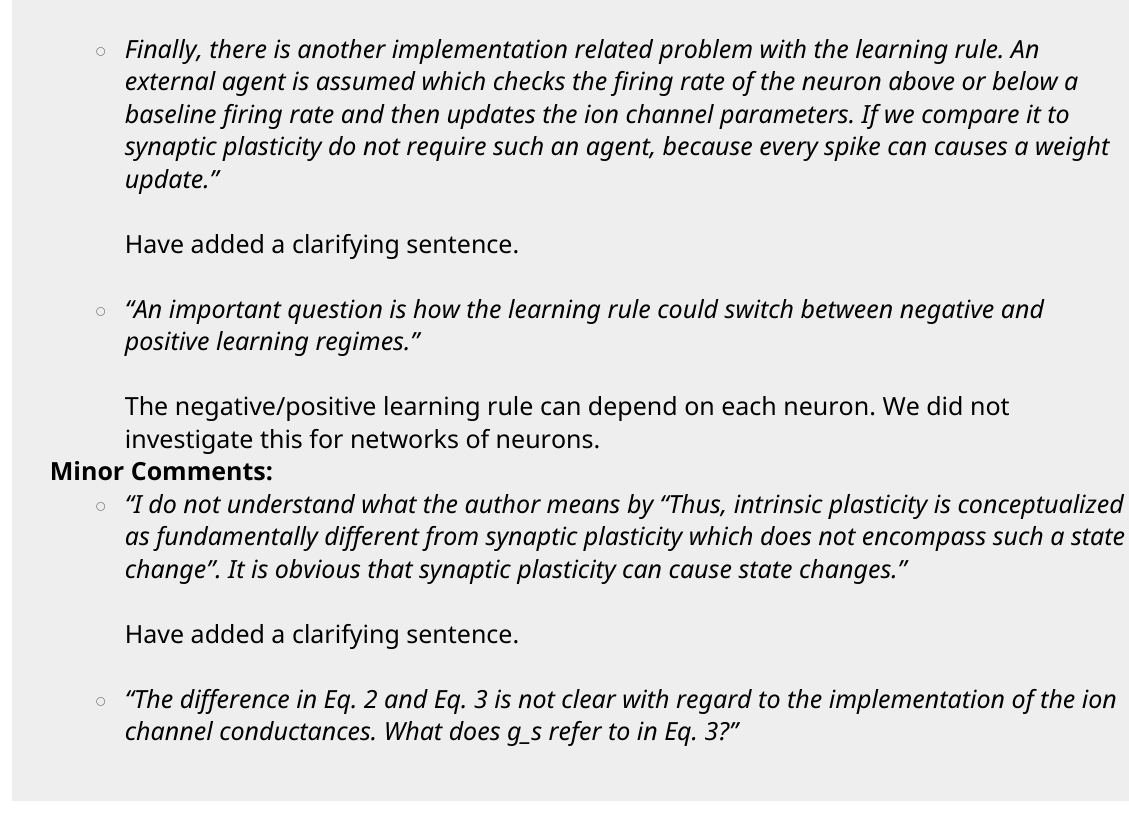
“Figure 4: Is there a range of μ values for which correlations fail to induce reliable spiking response. In general 0.9 is a very high correlation. How do the neurons behave for more acceptable correlations values e.g.